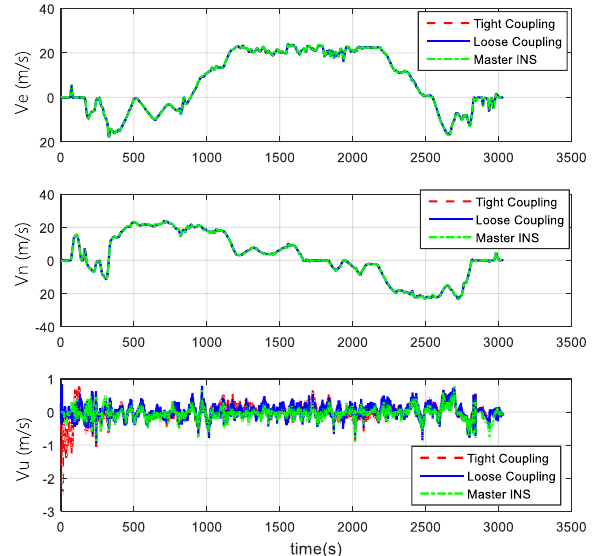
Figure 9. Velocity comparison of tight and loose coupling.